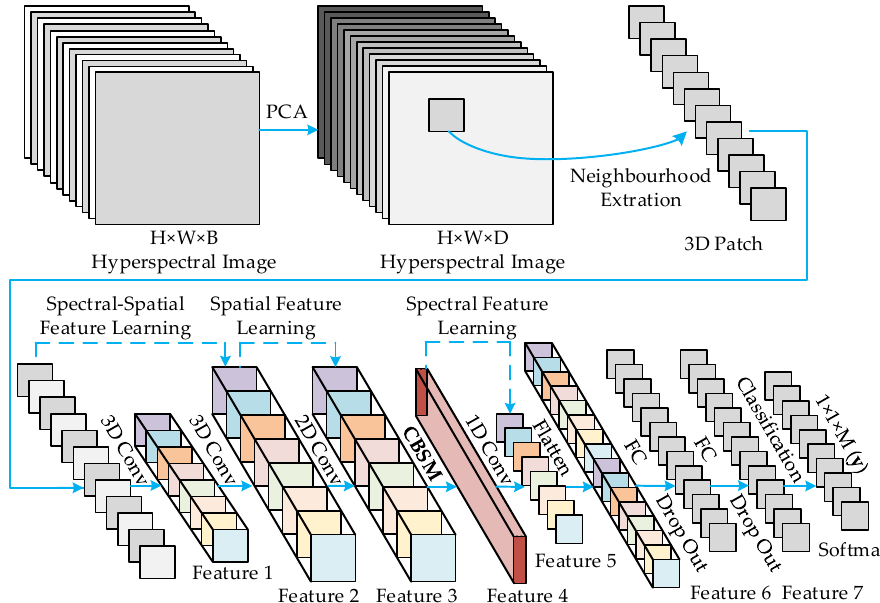
Figure 1. Architecture of the MDAN model; notably, the attention module CBSM is used to obtain the modified Feature 4.